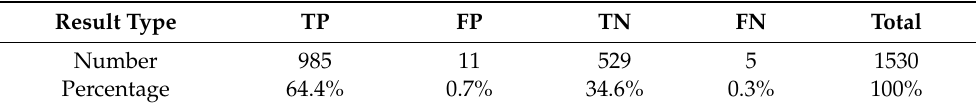
Table 4. SVM Training